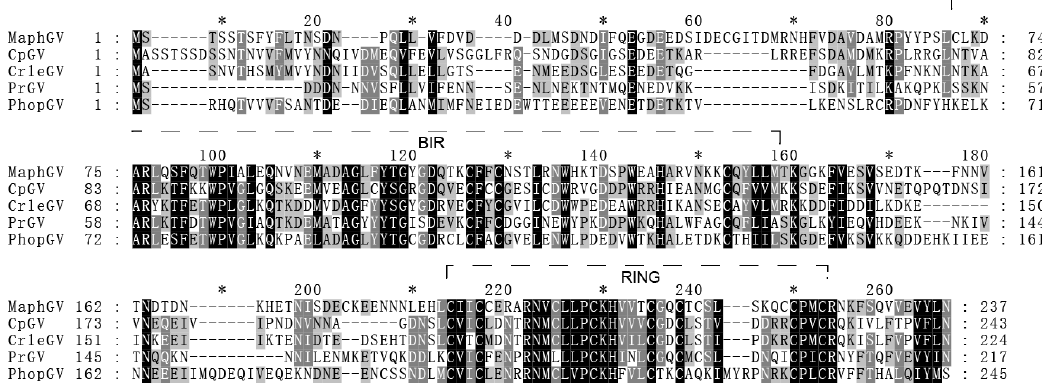
Figure 7. Predicted amino acid sequence alignment of IAP-6. The IAP-6 sequences of Phthorimaea operculella granulovirus (NP663251.1), CrleGV (NP891935.1), PrGV (YP003429403.1), CpGV (AIU37301.1), and MaphGV (this study) were aligned using MAFFT with default parameters. The identical amino acids are presented in white with a dark background, and the conserved ones are presented with a grey background. The BIR (71-142 aa) and RING (188-224 aa) domains of MaphGV iap-6 are indicated by the dashed lines.